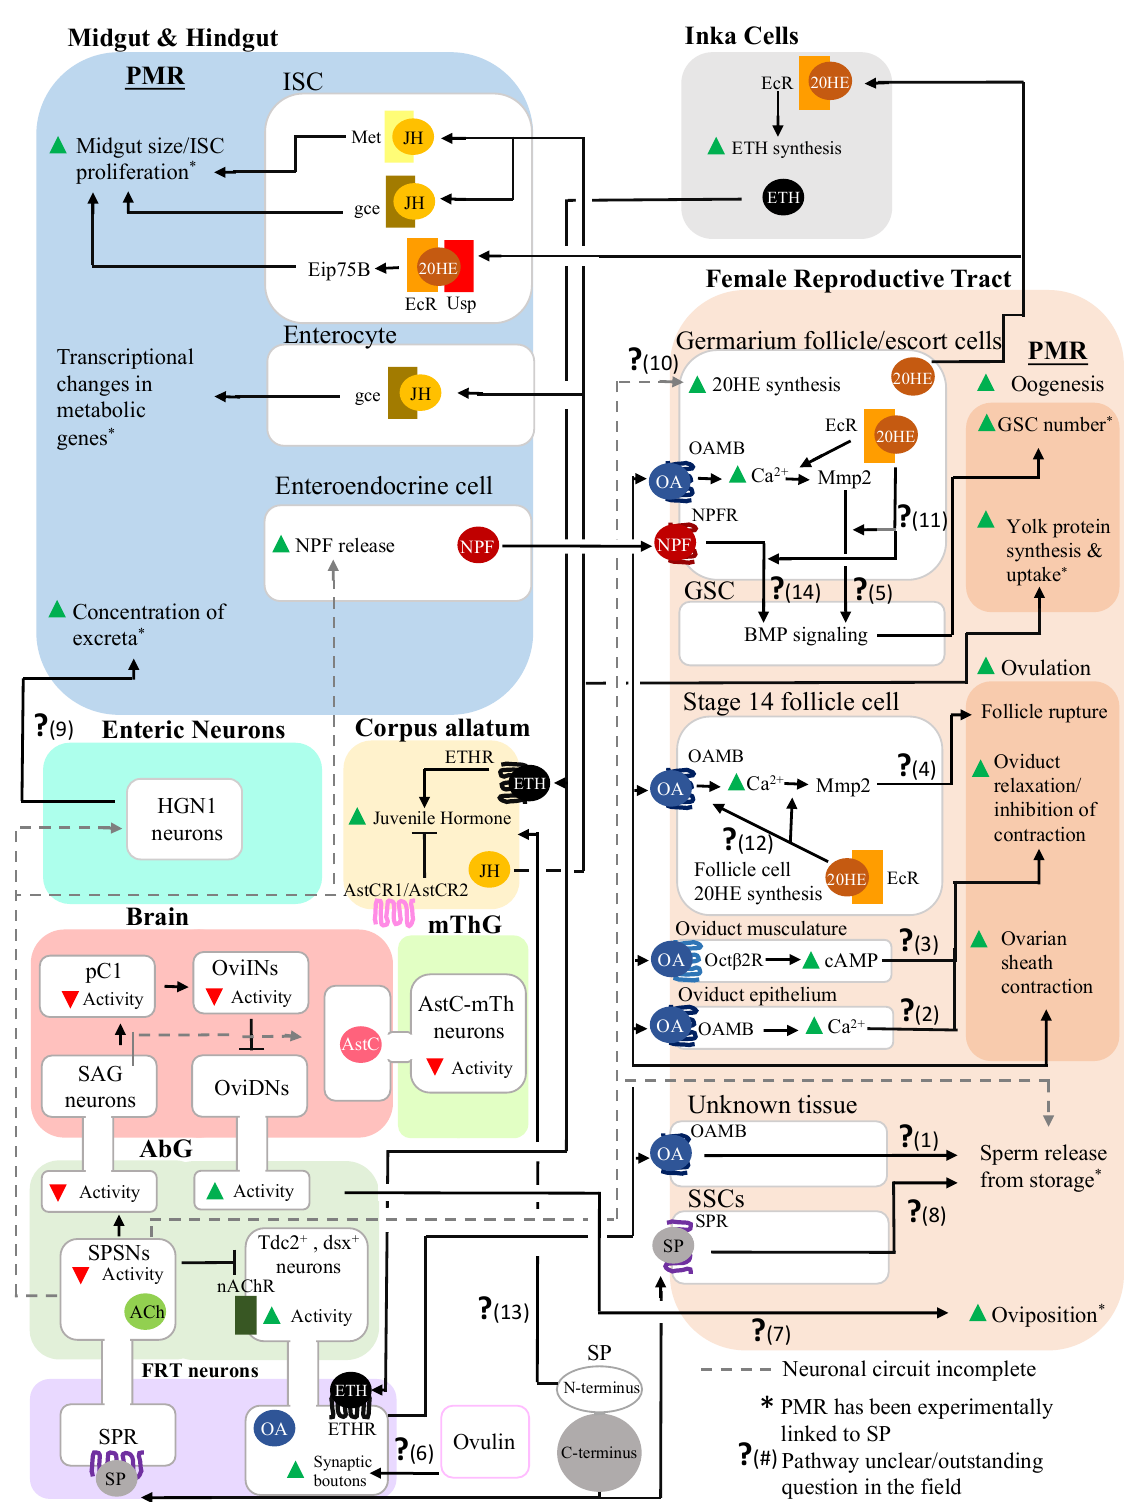
Figure 2. Network schematic of the signaling events within and between the digestive, nervous, and reproductive systems in response to seminal fluid proteins received during mating. Tissues are colored as in Figure 1. 20HE: 20-hydroxyecdysone, AbG: abdominal ganglion, Ach: acetylcholine, AstC: allatostatin C, AstCR1: allatostatin C receptor 1, AstCR2: allatostatin C receptor 2, cAMP: cyclic adenosine monophosphate, EcR: ecdysone receptor, ETH: ecdysis-triggering hormone, ETHR: ecdysis-triggering hormone receptor, FRT: female reproductive tract, Gce: germ cell expressed (a juvenile hormone receptor [36]), GSC: germline stem cell, ISC: intestinal stem cell, JH: juvenile